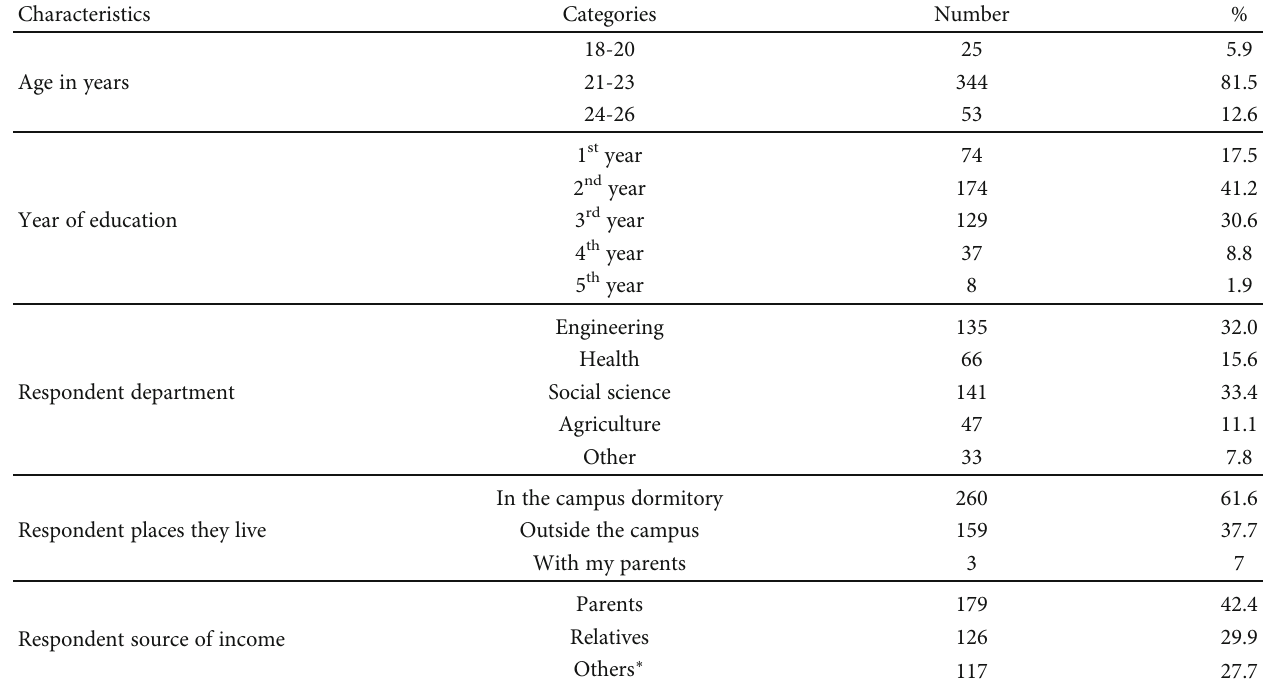
Table 1: Sociodemographic characteristics of female students in Hawassa University, SNNPR, Ethiopia, April 2019.